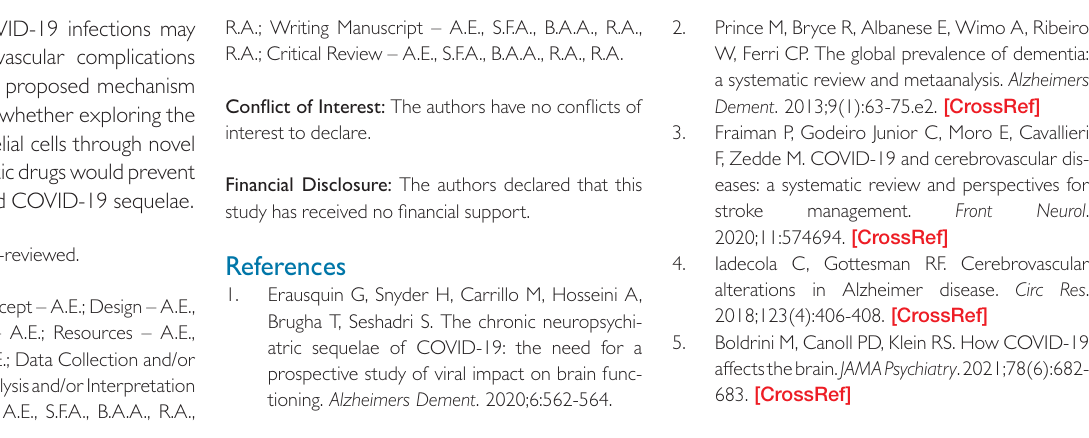
Figure 1. The pathological changes in Alzheimer’s disease lead to cerebrovascular alterations by causing vascular dysregulation, blood-brain barrier disruption, and promoting atherosclerosis. Created with